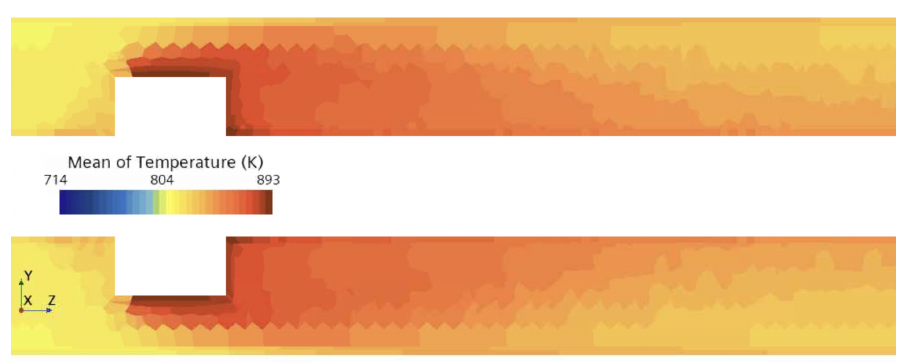
Figure 17. Axial profiles of center subchannel. ( a ) Snapshot of the velocity vector field. ( b ) Reynolds- averaged axial velocity contour plots. ( c ) Reynolds-averaged temperature contour